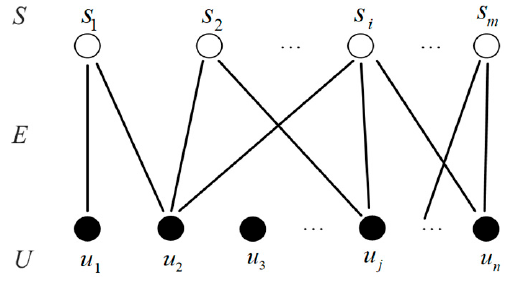
Figure 3. Undirected bipartite graph G .